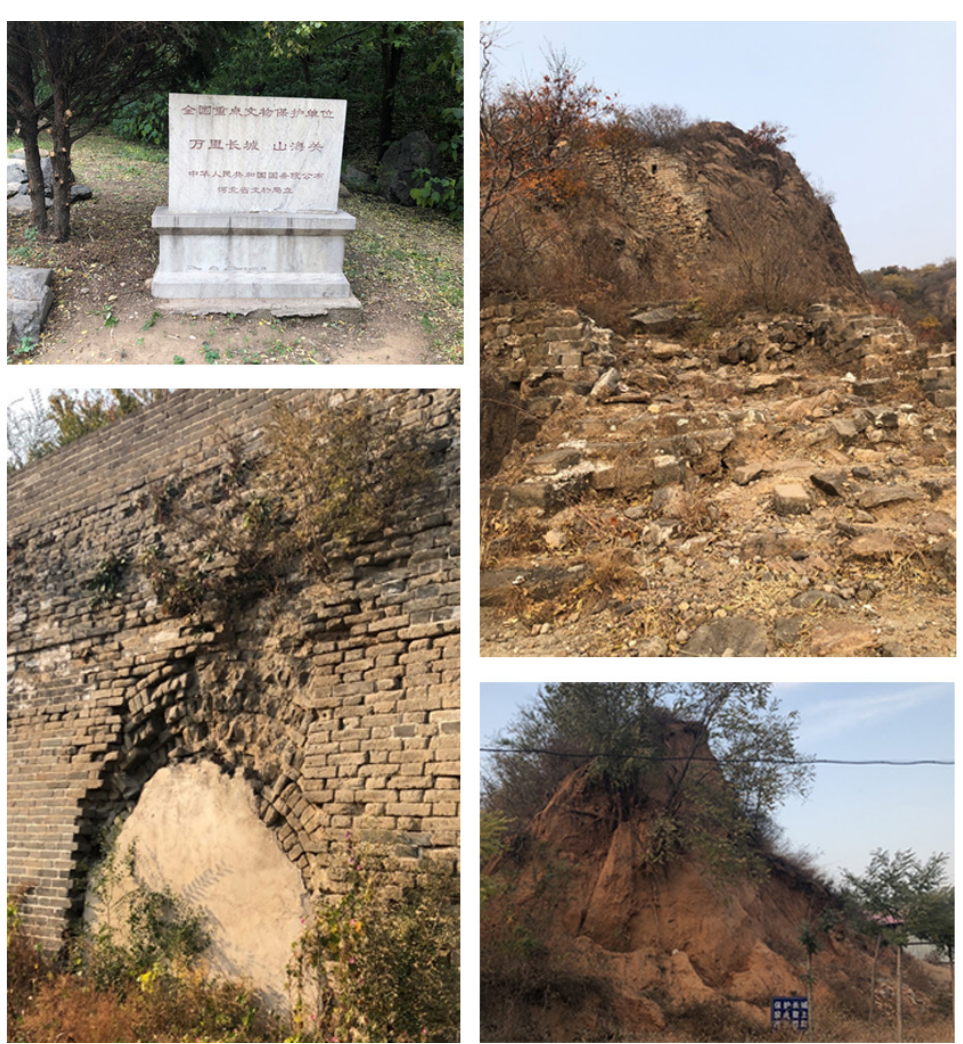
Figure 10. On-site photos of the Shanhaiguan section of the Great Wall.